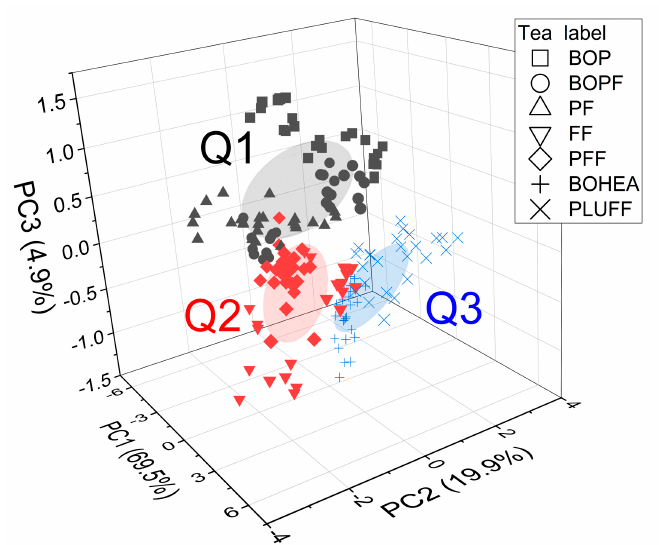
Figure 5. PCA 3D plots with confident level 50% regarding the unsupervised classification of tea samples from different brands (BOHEA, BOP, BOPF, FF, PF and PLUFF, as listed in Table 1) according to their quality grades (Q1, Q2 and Q3) based on the E-nose profiles after signal preprocessing data treatment using F 3 procedure. PC1, PC2 and PC3 are the 1 st , 2 nd and 3 rd principal component functions.